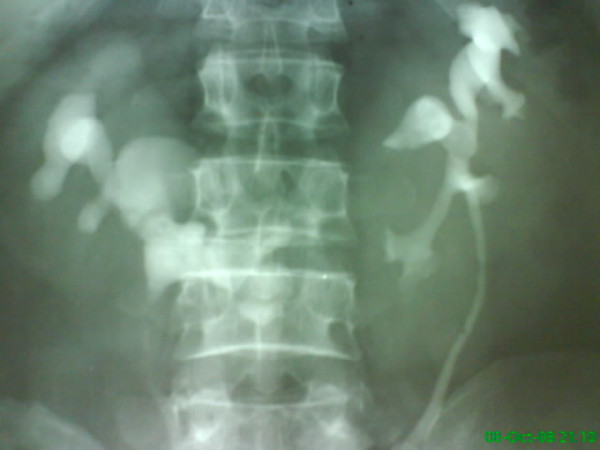
preoperative IVU.